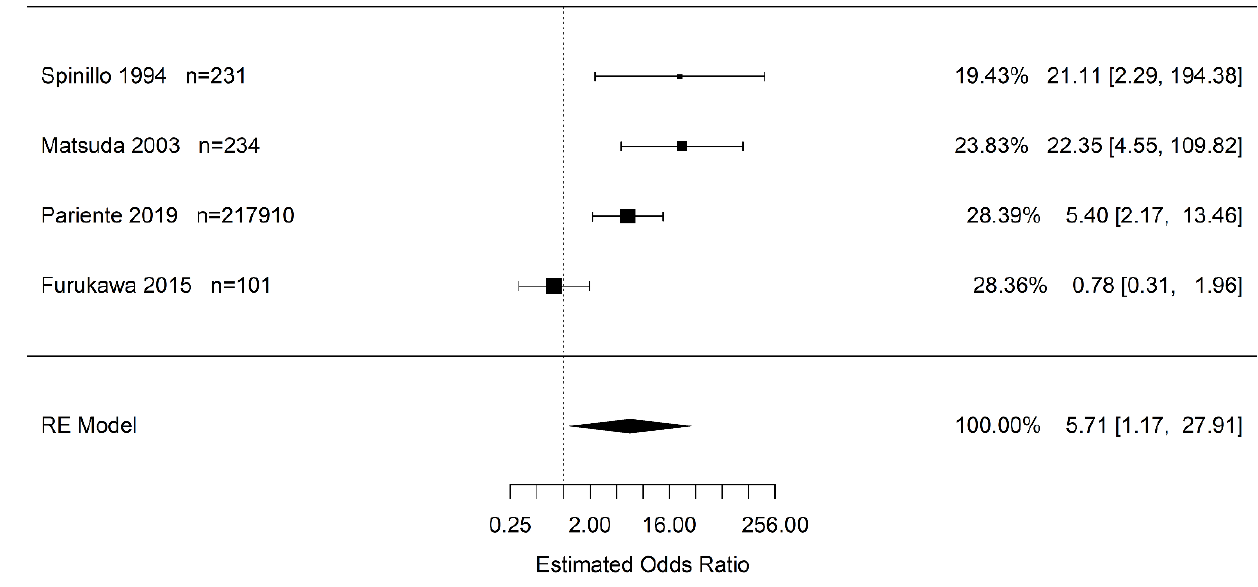
Figure 2. Estimate combined odds and hazard ratio of placental abruption (vs. “controls”) for cerebral palsy calculated using random effects (RE) model [24,30,45,47].